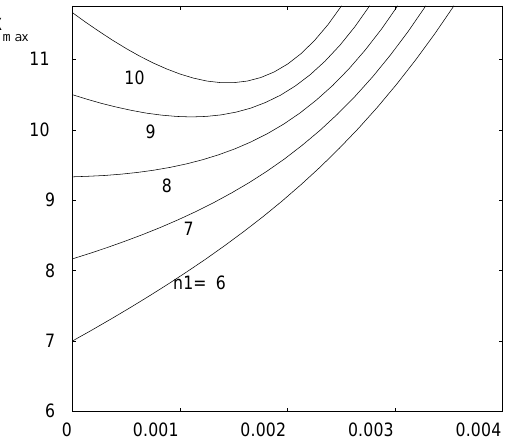
FIG. 6. The maximum transverse normalized excursion (cid:88) max of a particle as a function of the relative momentum offset d (cid:112) and of the primary collimator aperture (cid:110) (cid:49) . Each curve is ended at d (cid:112) (cid:173) d (cid:99) (cid:115) (cid:110) (cid:49) (cid:100) where (cid:88) max (cid:173) (cid:78) (cid:97)(cid:114)(cid:99) (cid:173) (cid:49)(cid:49)(cid:46)(cid:56) , a case study for LHC for which we fixed the ratio (cid:110) (cid:50) (cid:121) (cid:110) (cid:49) (cid:173) (cid:55) (cid:121) (cid:54)